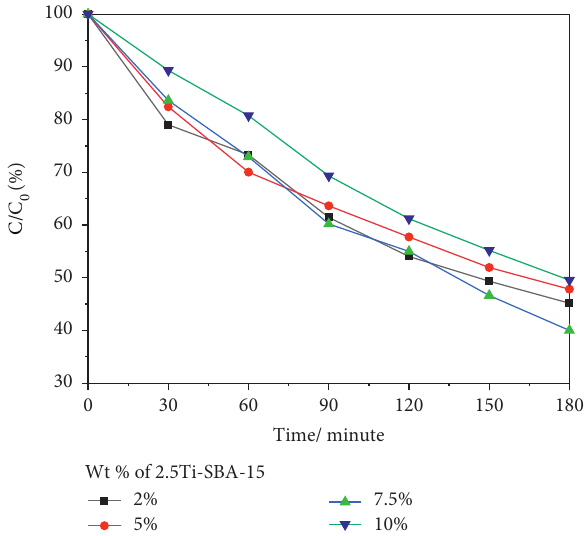
Figure 10: The effect of various amounts of 2.5Ti-SBA-15 in 2.5Ti- SBA-15/C 3 N 4 .